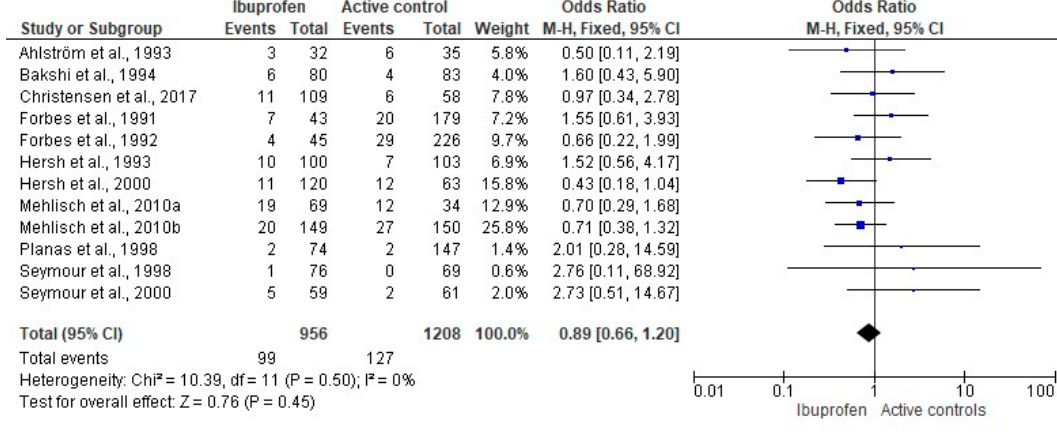
Figure 5. Pooled comparison of adverse effects after third molar surgery.